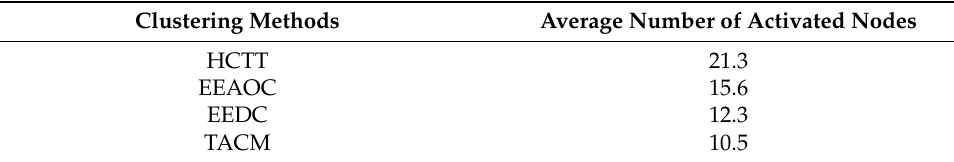
Table 2. Average number of activated nodes in 1000 time